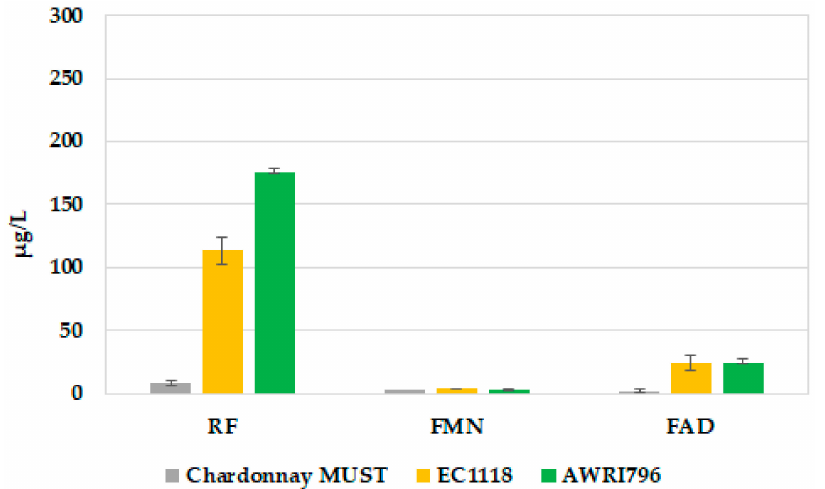
Figure 7. Extracellular FDs released at the end of the large-scale fermentation processes. Yellow bars indicate S. cerevisiae EC1118, and green bars S. cerevisiae AWRI796. Grey bars show the content of FDs in Chardonnay must. The results are reported as average data of three replicates, and the error bars indicate the standard deviations ( n =